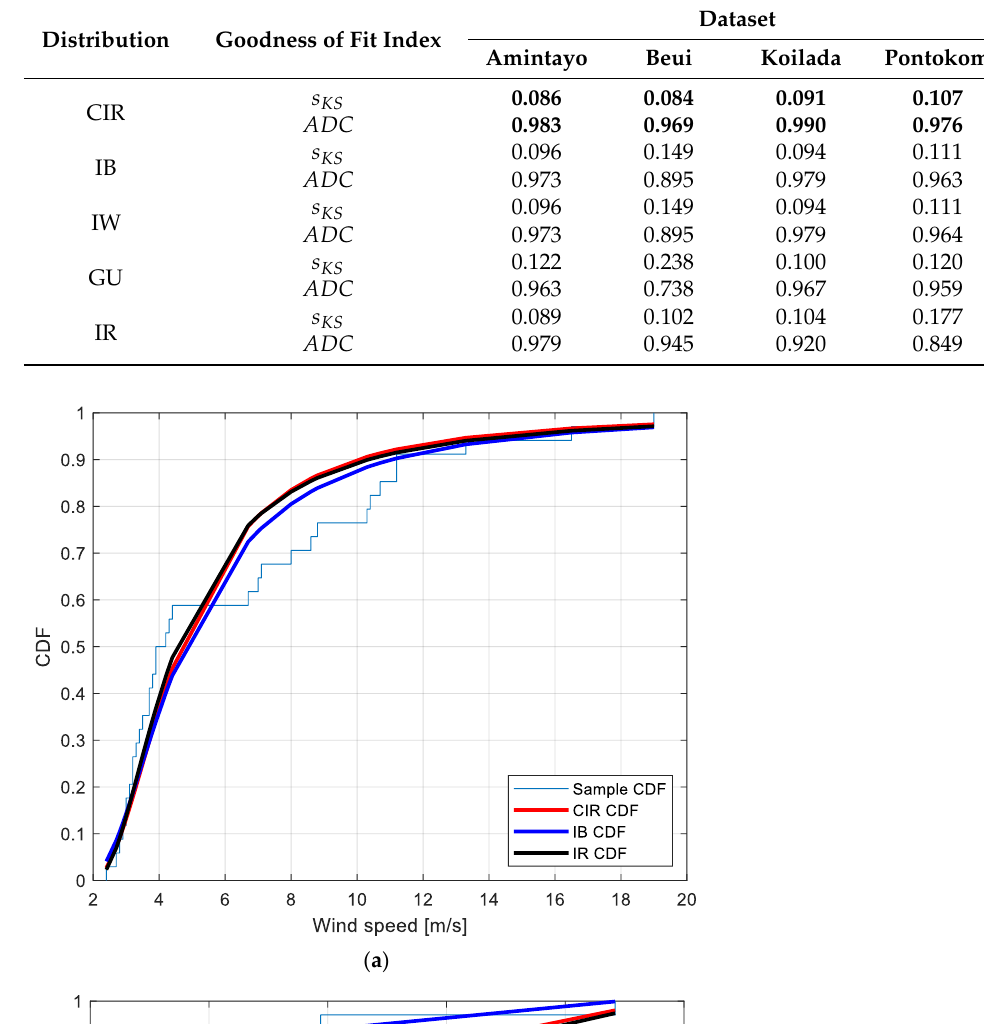
Table 4. Goodness of fit of the CIR distribution and of the benchmark distributions on the POT EWS datasets. Bold values indicate the best results for each location.